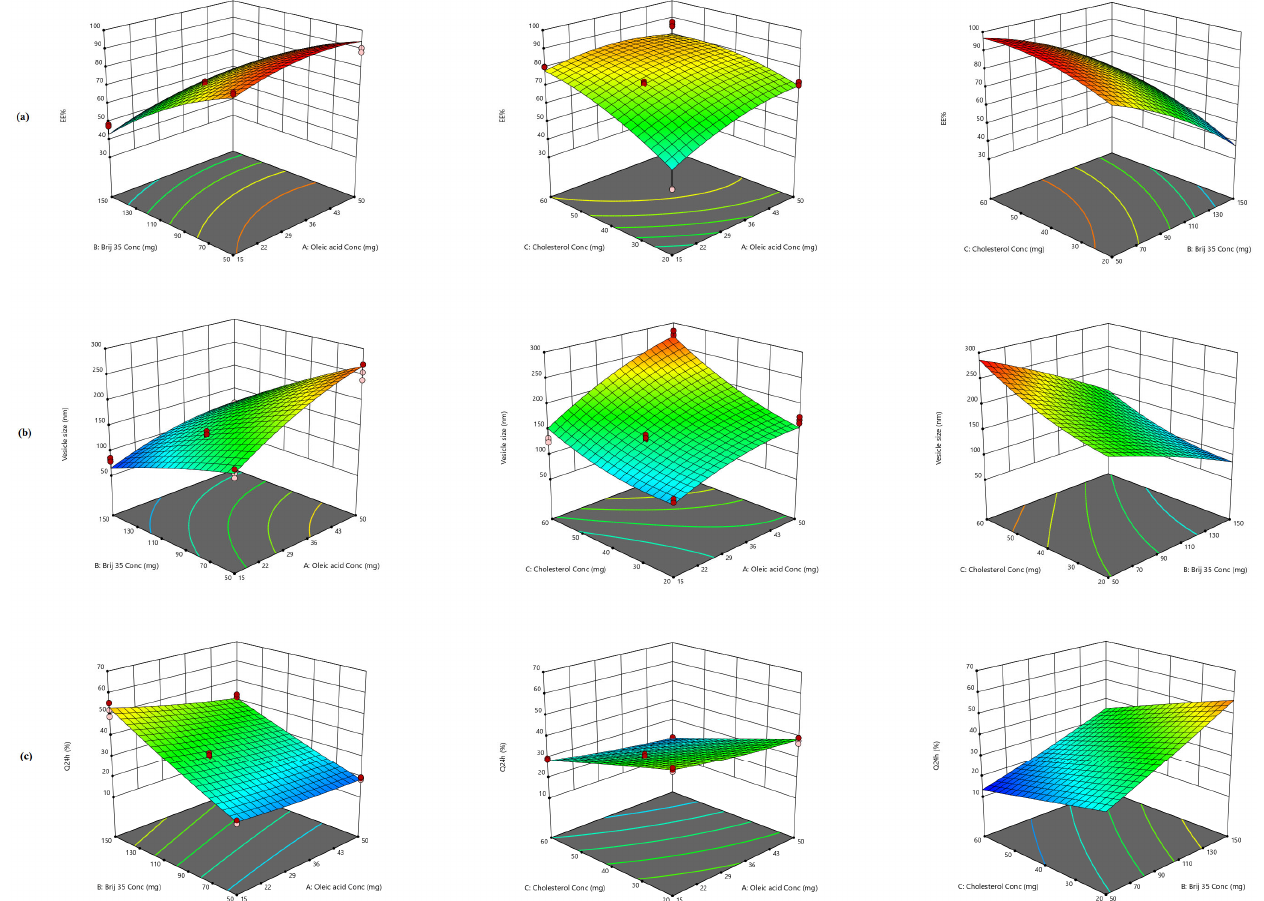
Figure 1. Response surface 3D plot for the effect of oleic acid ( X 1 ), Brij 35 ( X 2 ), and cholesterol ( X 3 ) concentrations on ( a ) EE% ( Y 1 ), ( b ) vesicle size ( Y 2 ), and ( c ) Q 24h ( Y 3